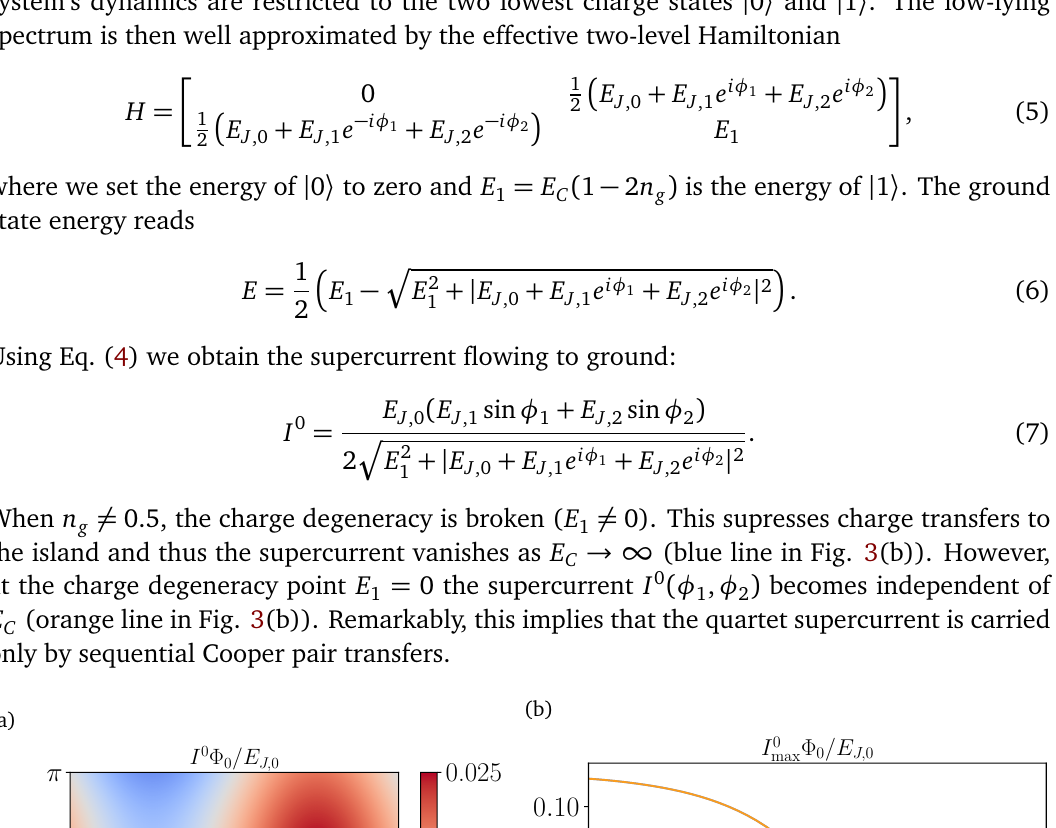
Figure 3: (a) Instantaneous current across the E Fig. 1(a) with E quartet supercurrent: the current I the electrodes max φ states | 0 〉 and | 1 〉 are degenerate, allowing quartet supercurrent to flow with single Cooper pair transfers. The solid lines are obtained by numerically di- agonalizing the full Hamiltonian (3), while the dashed lines are given by the approximate analytical expression (7), valid in the high E